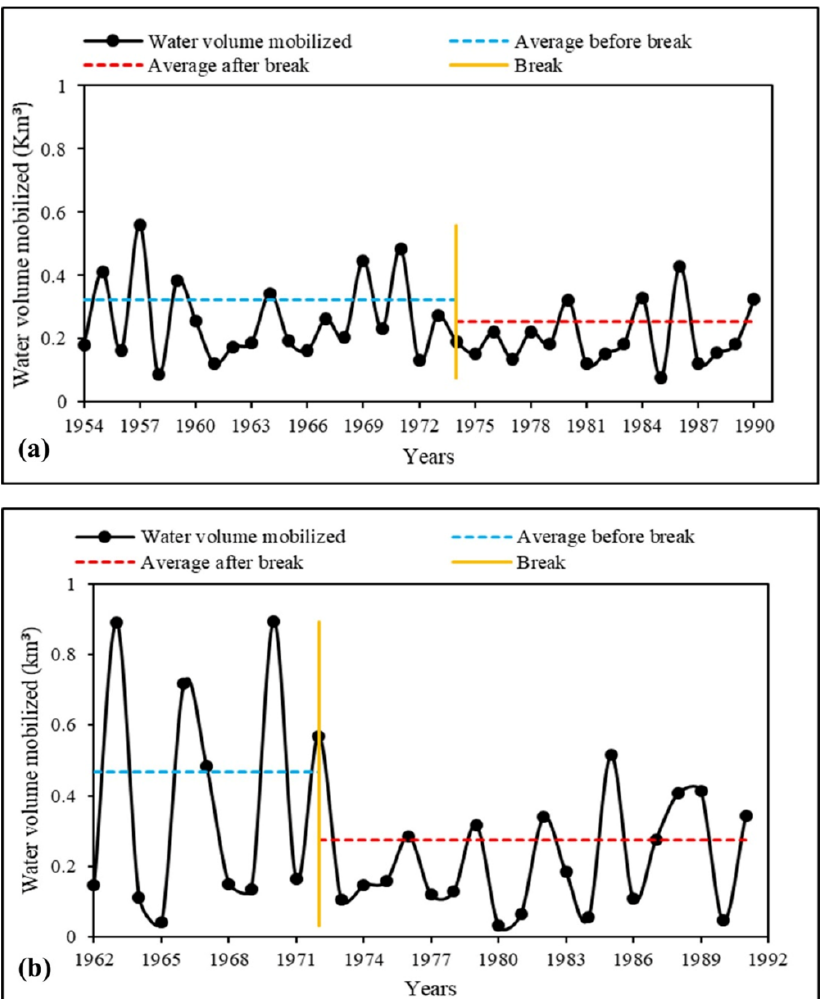
Figure 10. Variation of the water volume mobilized by the aquifers at the Kara ( a ) and Kpéssidè ( b ) stations.